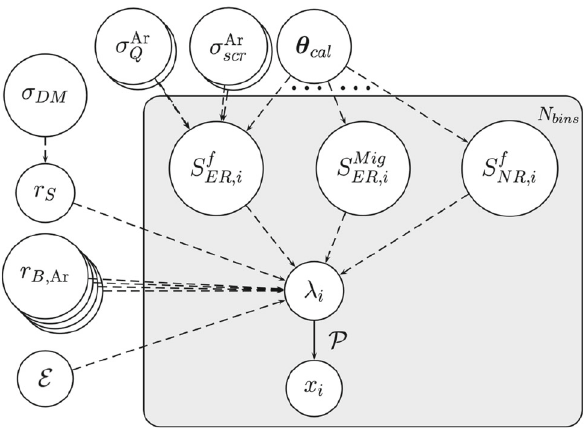
Fig. 3 Bayesian network for the DS-50 low-mass analysis: the node x i is the observed number of events in the i -th bin; λ i is the intensity of the Poisson process in the i -th bin; the gray box contains the nodes and connections that are repeated over the total number of bins N bins ; the dots represent the portion of the network implementing the detector response model in the form of the two smearing matrices M 1 and M 2 ; besides σ DM , which is directly related to r S in our case, all the nodes outside the gray box are the free parameters of the likelihood, as described in Sect.